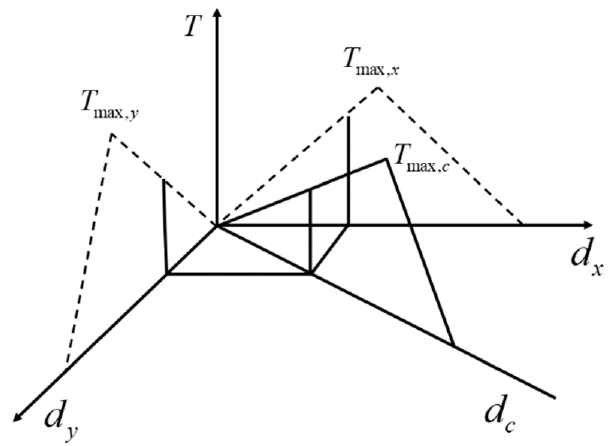
Figure 3. Schematic diagram of right-angle coupling between the tangent planes.